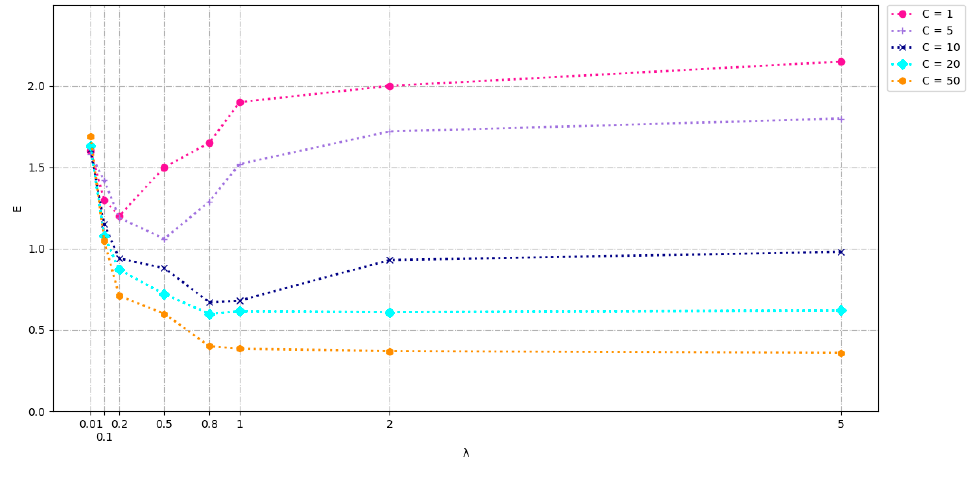
λ Figure 3. and C in Dataset 1. λ Figure 3. λ and C in Dataset 1. Figure 3. and C in Dataset 1.